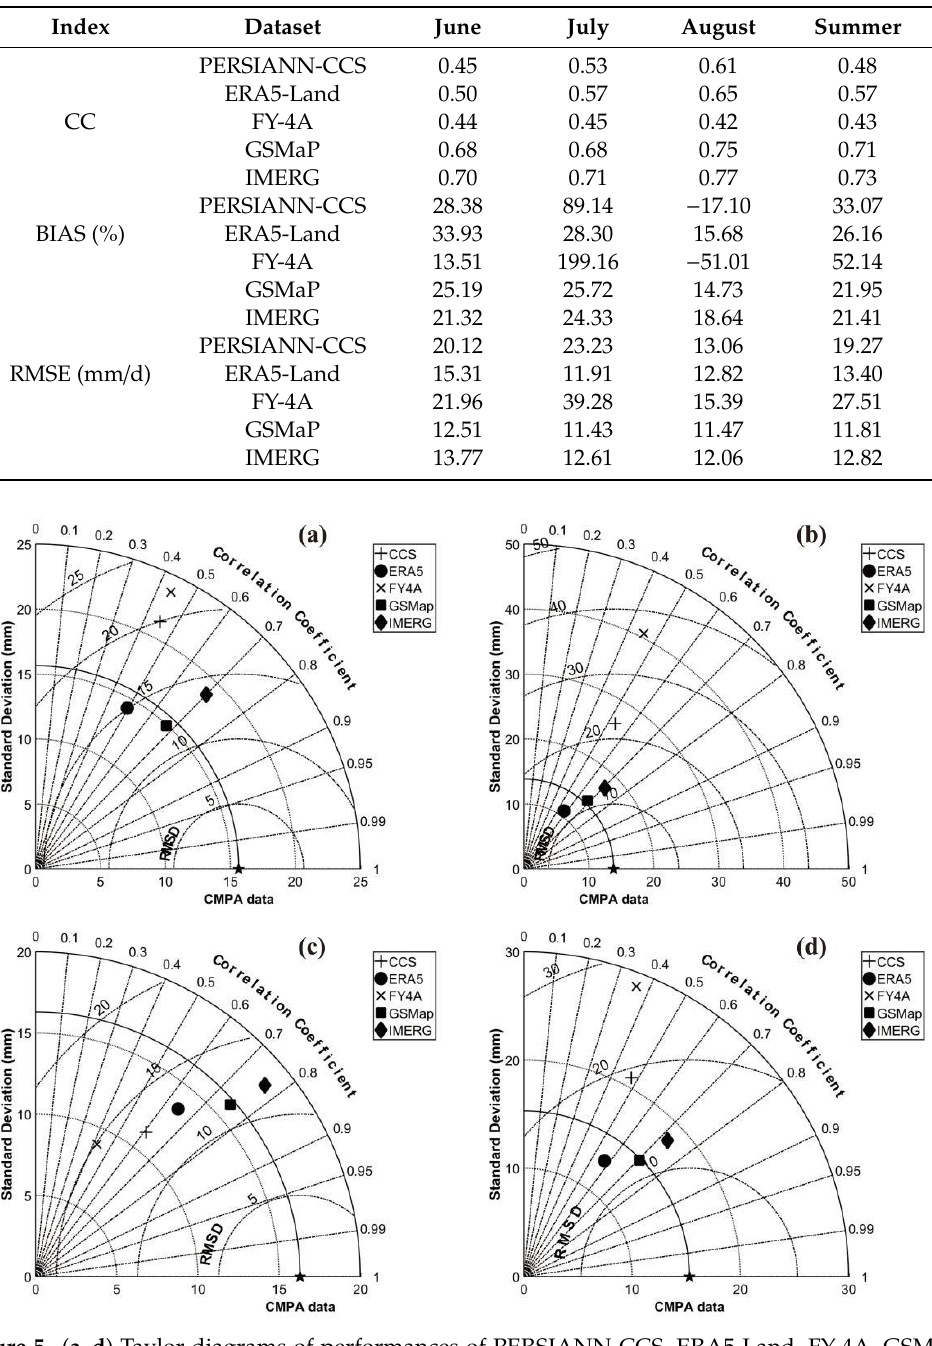
Figure 5. ( a – d ) Taylor diagrams of performances of PERSIANN-CCS, ERA5-Land, FY-4A, GSMaP, and IMERG against CMPA in terms of the centered root-mean-square difference, correlation coefficient, and standard deviation.